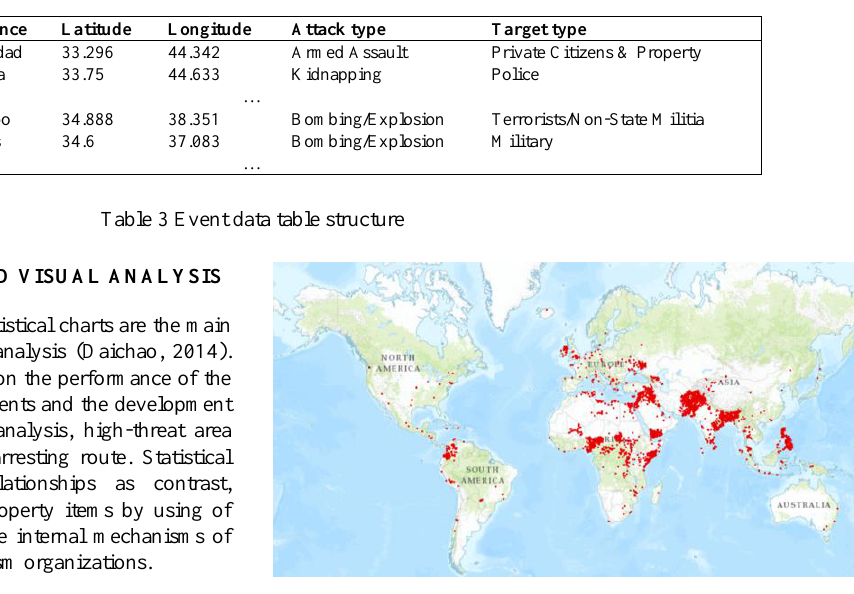
Figure 1 Distribution of global terrorism events of year 2014 Adding time element on spatial thematic map can help to perform the development of terrorism events’ spatial and thematic characteristics in time domain. Time factor can be expressed in two ways: horizontal time axis and vertical time